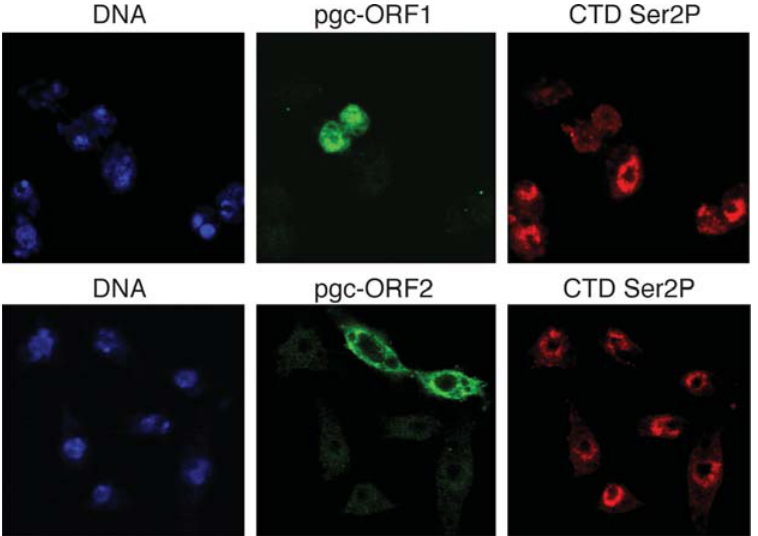
Figure 2. Pgc ORF1 abolishes Ser2 phosphorylation on the RNA polymerase II CTD. Transfected Drosophila Kc cells fixed one day after inducing the expression of V5-(His) 6 -tagged Pgc ORF1 and ORF2. Pgc-expressing cells are revealed by anti-V5 antibody (middle panels). Upper panels show that Pgc ORF1 decreases CTD Ser2 phosphorylation (detected using H5 monoclonal anti-phospho-Ser2 antibody). There is no change in CTD Ser2 phosphorylation upon expression of Pgc ORF2 (lower panels).